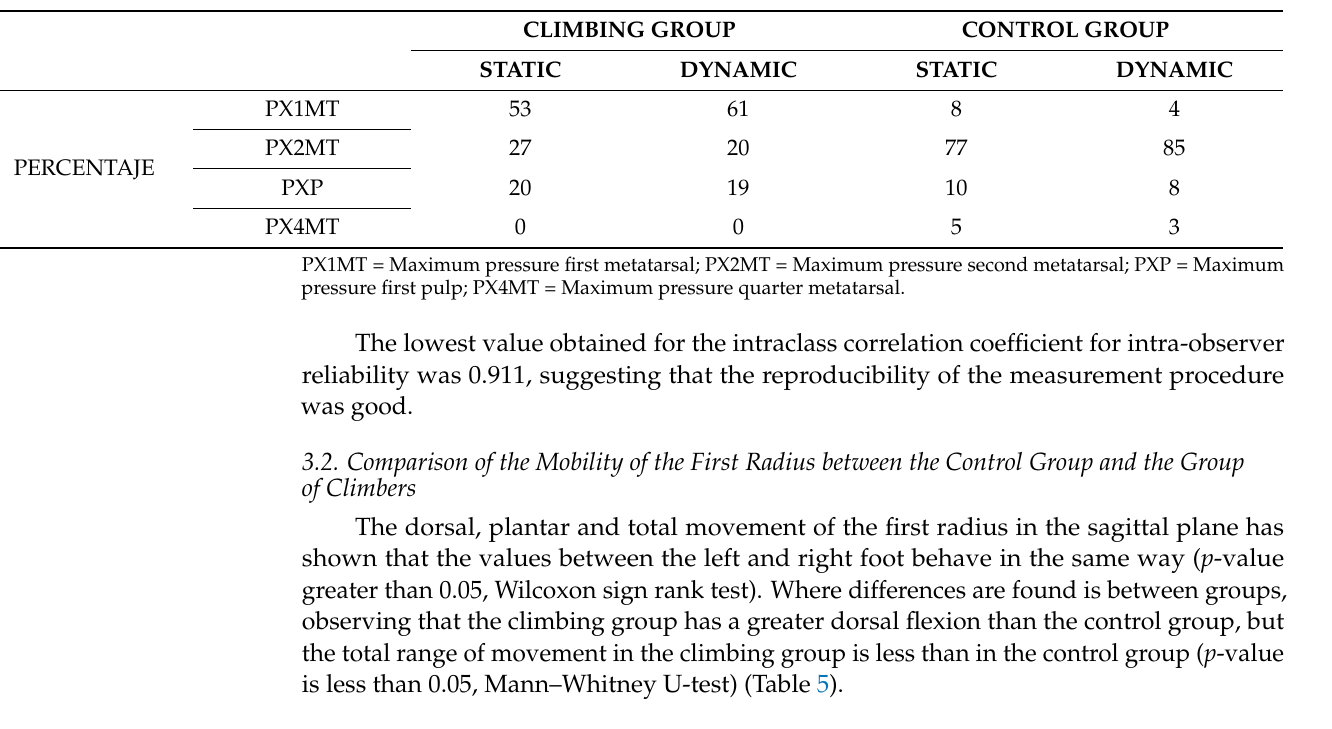
Table 5. Movement of the first radio of all